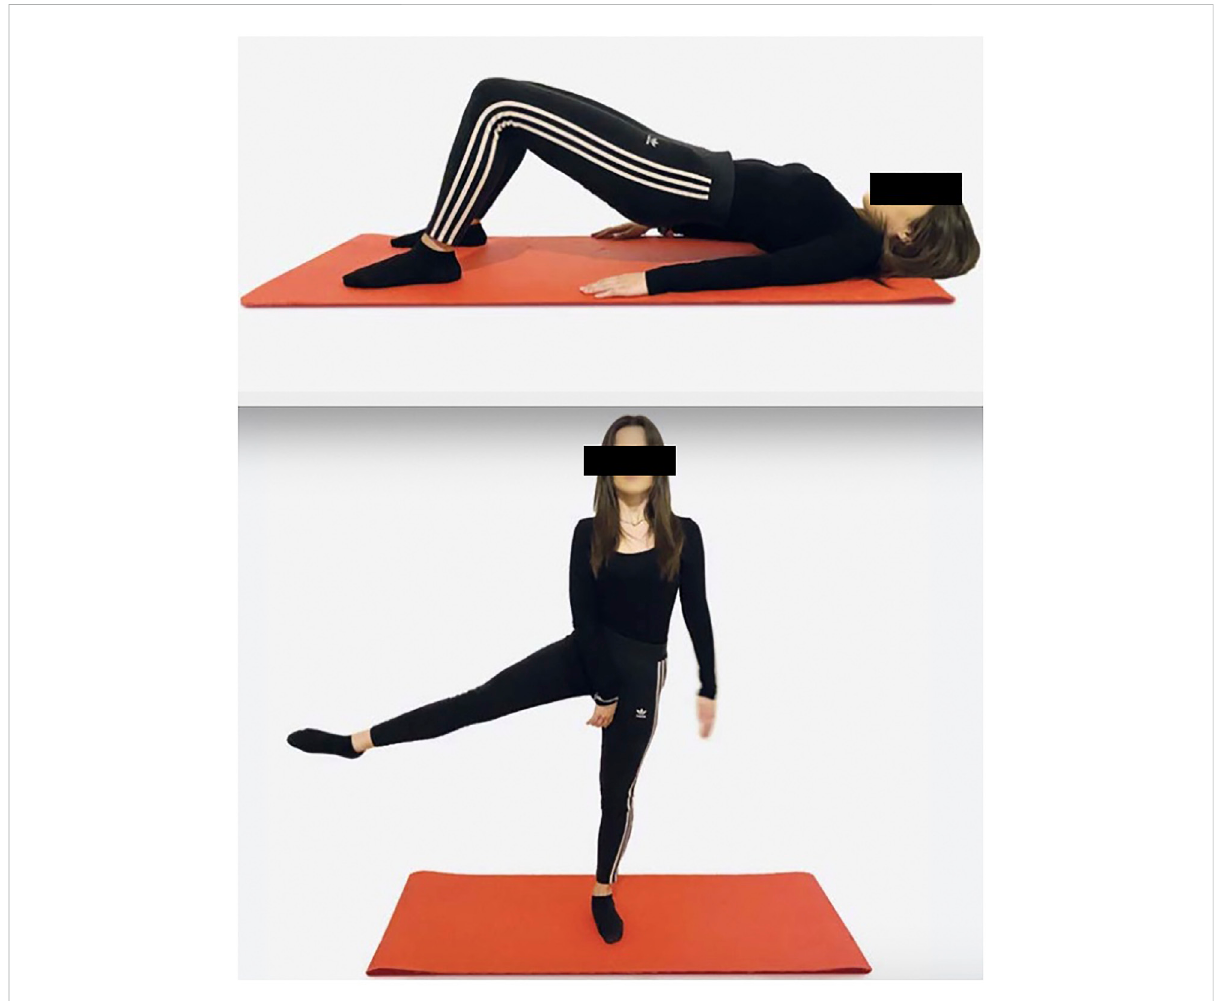
FIGURE 1 “ Bridge ” exercise and maintaining balance in mono-podalic support with hip